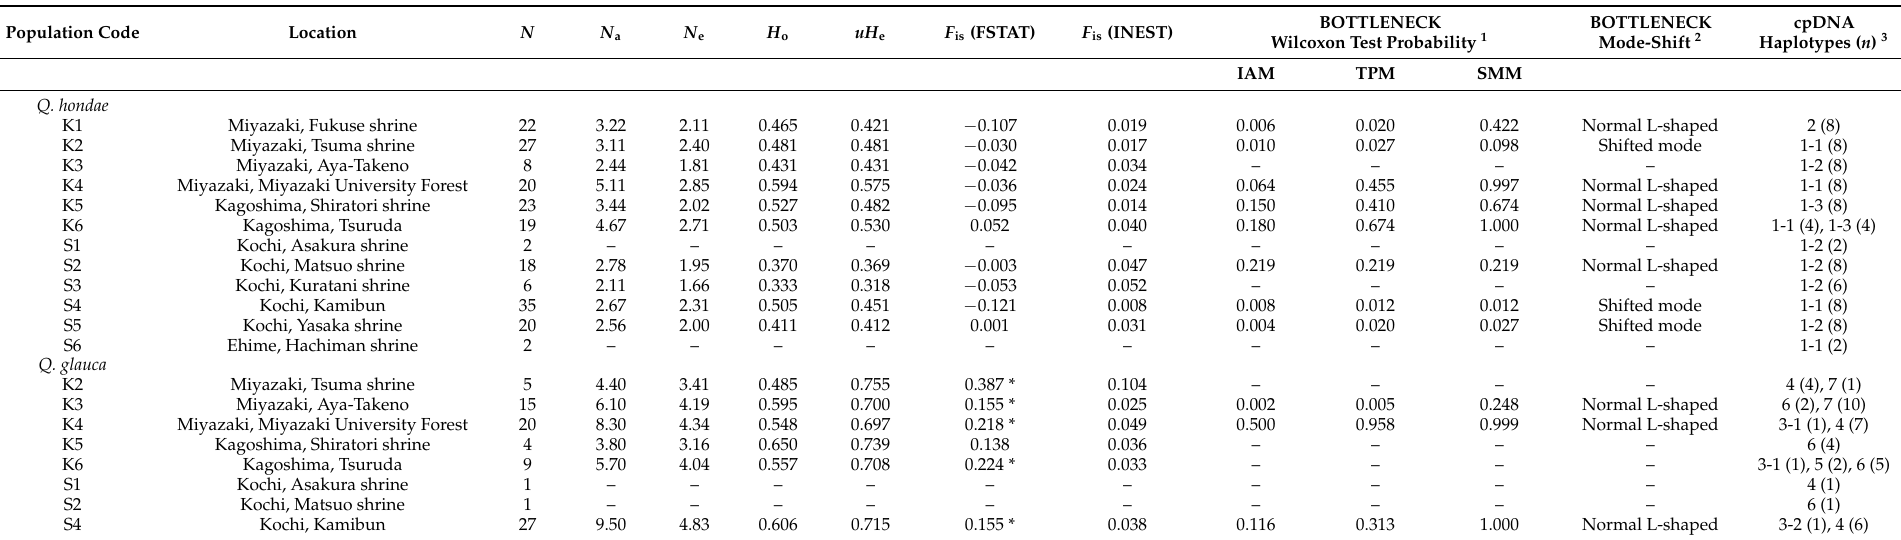
Table 1. Populations sampled and the statistics of genetic diversity. Population